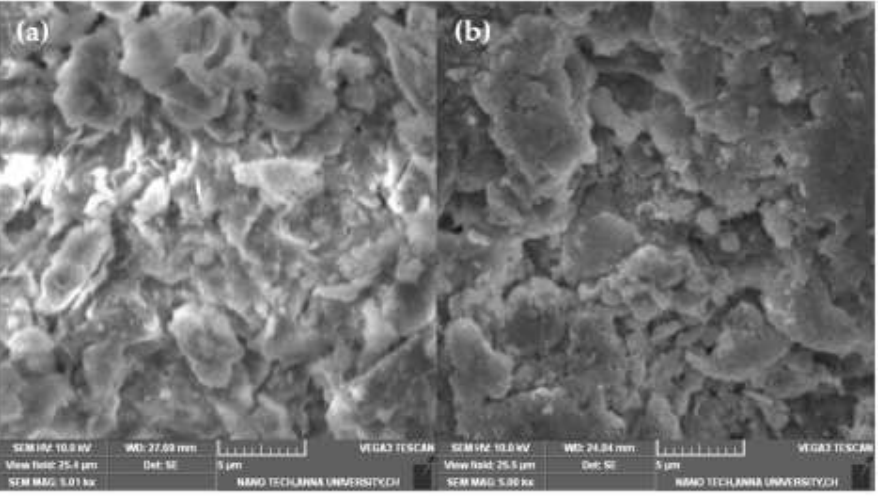
Figure 8. SEM Micrograph of ( a ) LP1 ( b ) LP2.